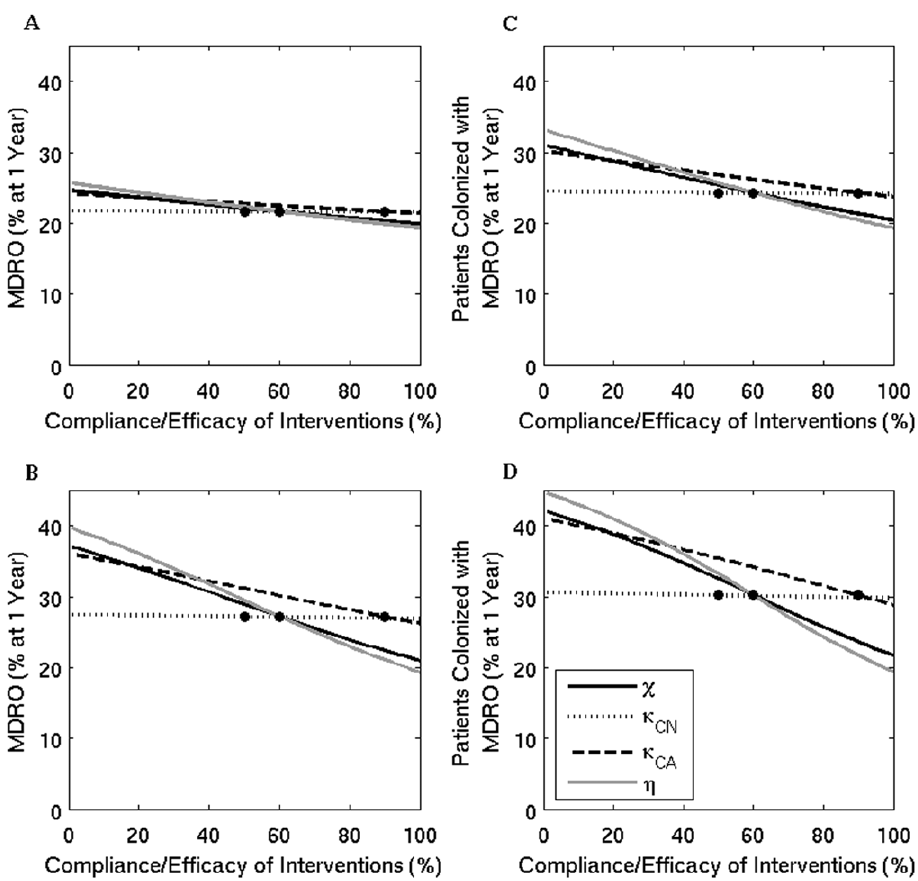
Figure 5. The percent of patients colonized with an MDRO at one year when the compliance or efficacy of four interventions are varied for four transmission levels. Solid black line ( x ) - contact precautions, dotted line ( k CN ) - screening of colonized patients not on antimicrobials, dashed line ( k CA ) - screening of colonized patients receiving antimicrobials, and grey line ( g ) - compliance with hand hygiene measures. The dots mark the baseline values. (A) b CA ~ 0 : 2 ; (B) b CA ~ 0 : 4 - baseline value used in other simulations; (C) b CA ~ 0 : 6 ; and (D) b CA ~ 0 : 8 .